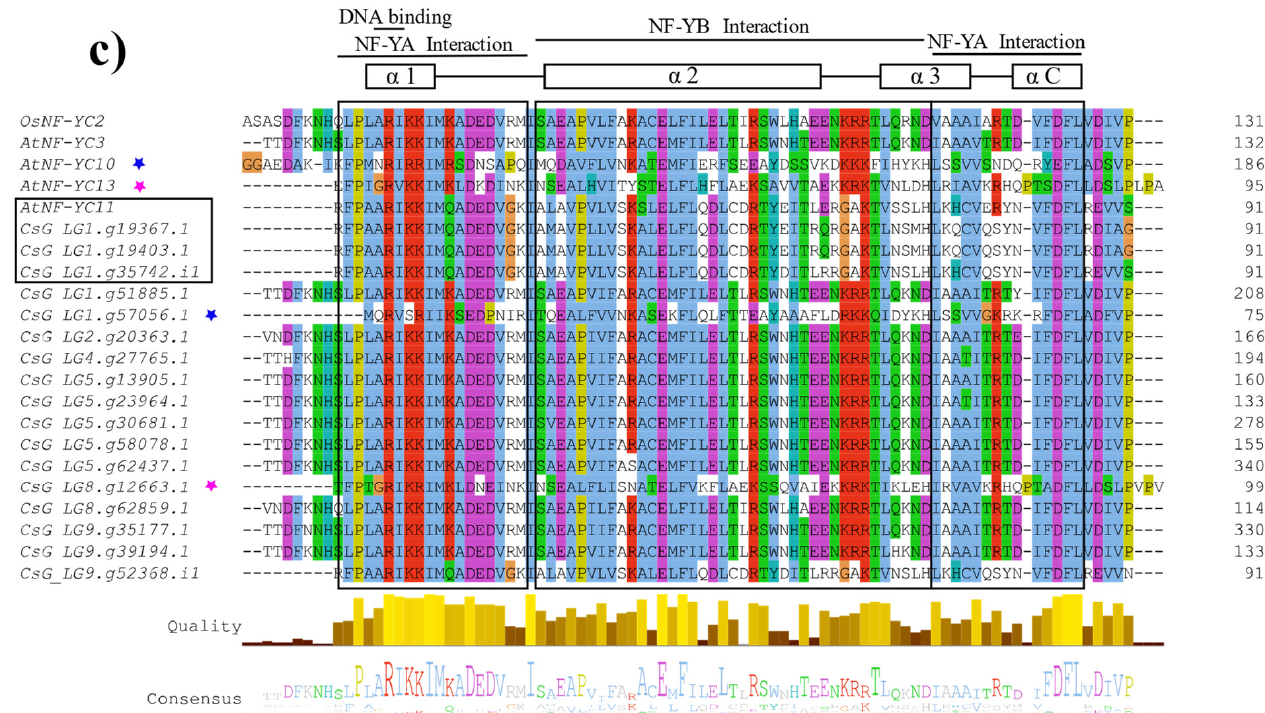
Figure 2. The details of conserved domains in the three subfamilies of CsNF-Ys Subunit interaction and DNA binding regions of conserved domains are marked. The numbers followed the gene number are the conserved domain ranges. Below the sequences are the amino acid enrichment analysis and above the sequences are the domain analysis. ( a ) CsNF-YA subunit; ( b ) CsNF-YB subunit; ( c ) CsNF-YC subunit: stars represent the presence of CsNF-YC genes with structural similarity to the particular branch of AtNF-YC and NF-YCs with structurally similar stars of the same color.